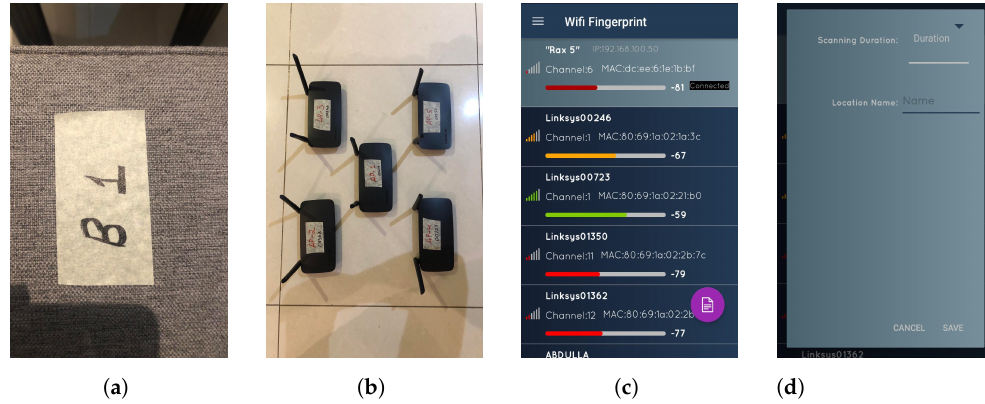
Figure 10. Basic elements of the fingerprinting experiment. ( a ) Grid mark; ( b ) APs used in the experiment; ( c ) Fingerprint utility home screen; ( d ) Fingerprint utility RSS sample collection.